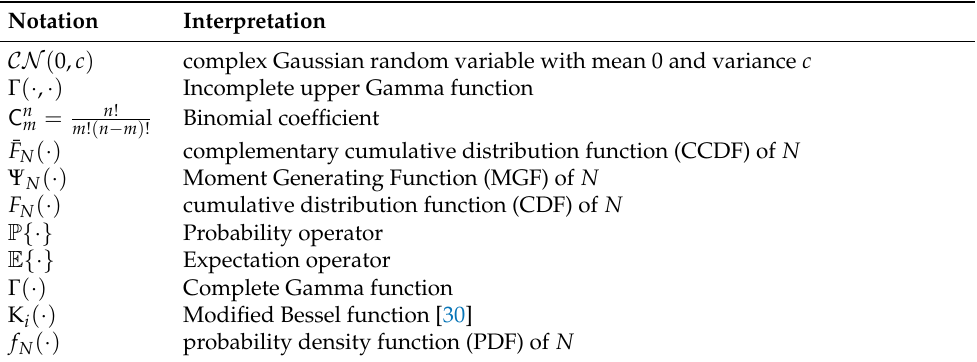
Table 1. Frequentlyused